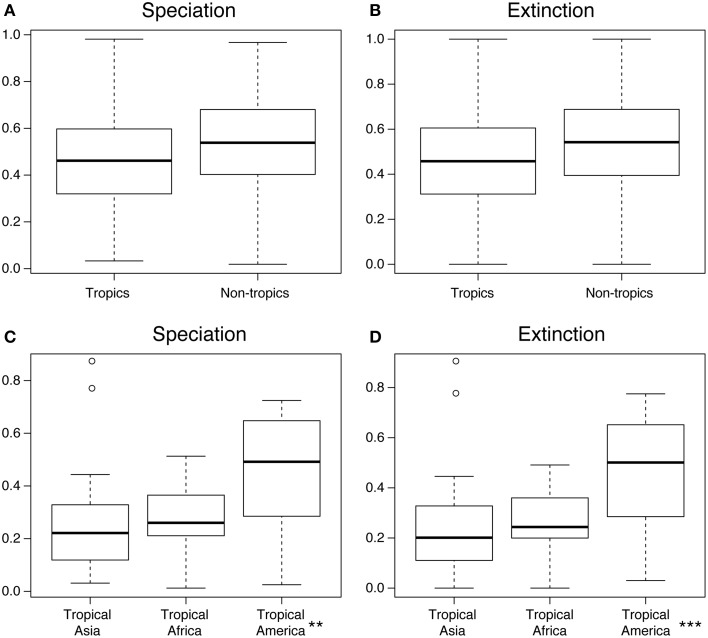
Results from the diversification rate analyses under the MuSSE model. (A) Speciation rates per geographic region (tropical vs. non-tropical); (B) Extinction rates per geographic region (tropical vs. non-tropical); (C) Speciation rates for the three tropic regions; (D) Extinction rates for the three tropic regions. All results are normalized against each other. Each data point represents an angiosperm plant order (Table 2). Boxes indicate the interquartile range (IQ) of all estimates, with the median shown as a horizontal line and the whiskers indicating data range outside the quantiles. ** and *** denote significant differences (p < 0.05 and p < 0.001, respectively; ANOVA). See Methods for details.